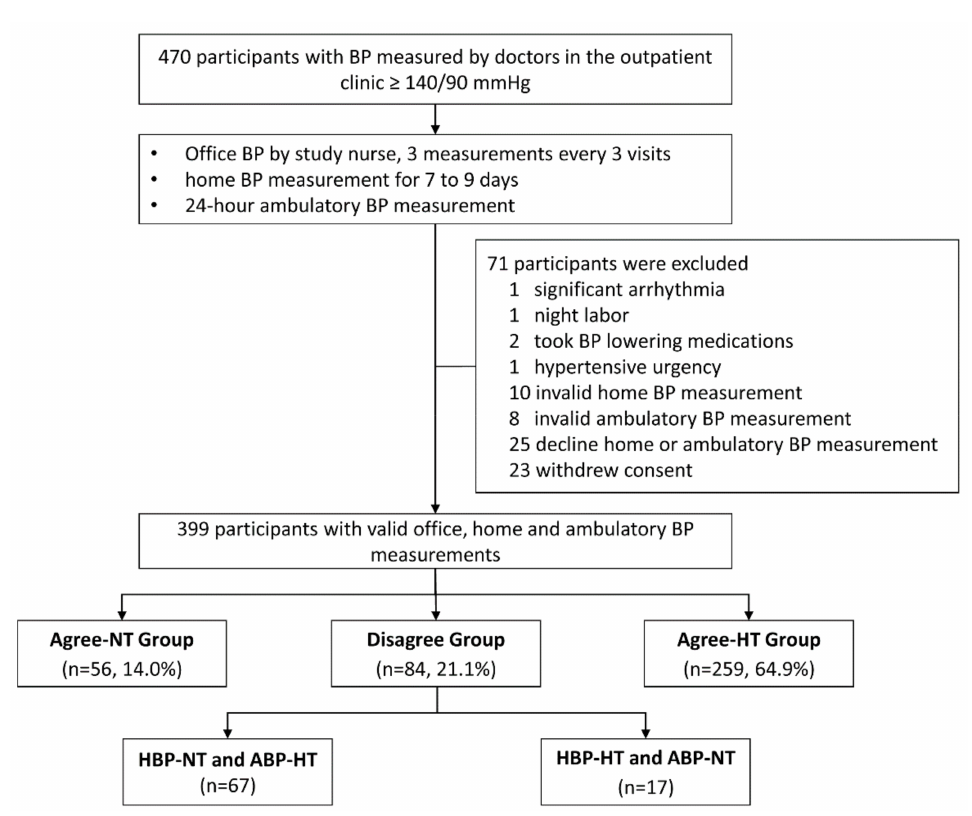
Figure 1. Patients’ dispositions. BP, blood pressure; Agree-NT group, home and daytime